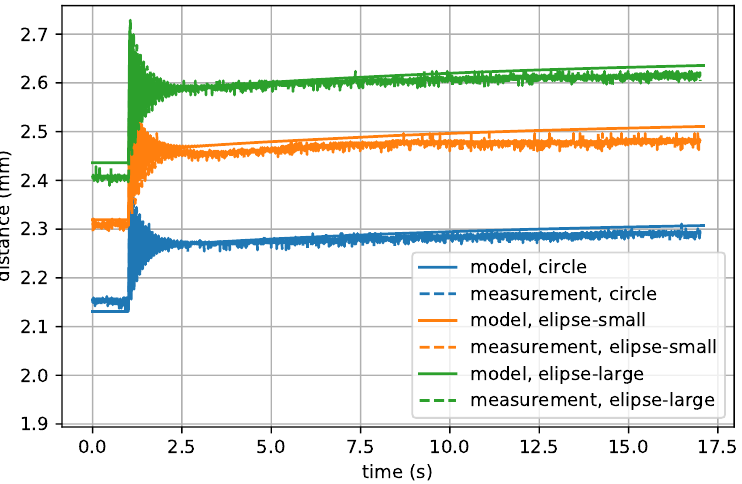
Figure 9. Response of the DEAP actuator for a step voltage signal from 0kV to 3.5kV with load of